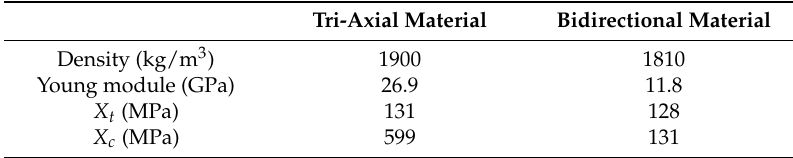
Table A1. Blade materials.